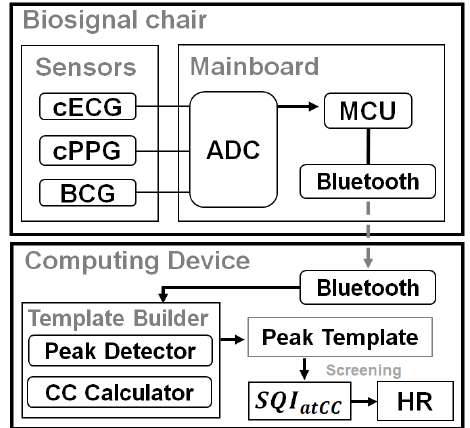
Figure 1. System structure and process. ADC: analog-to-digital converter, MCU: microcontroller unit, atCC: averaged template cross-correlation, SQI: signal quality index, HR: heart rate.